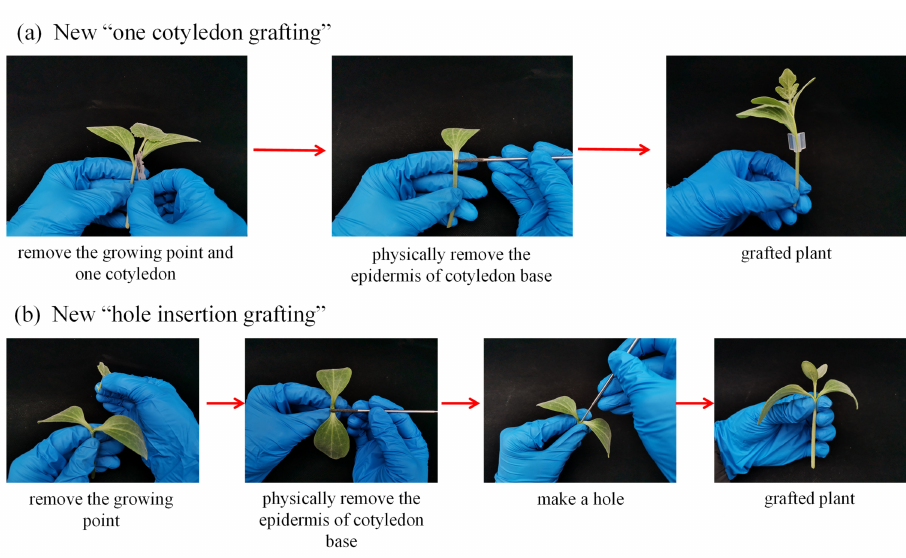
Figure 2. Pictures showing how the new “one cotyledon grafting” ( a ) or “hole insertion grafting” ( b ) method is